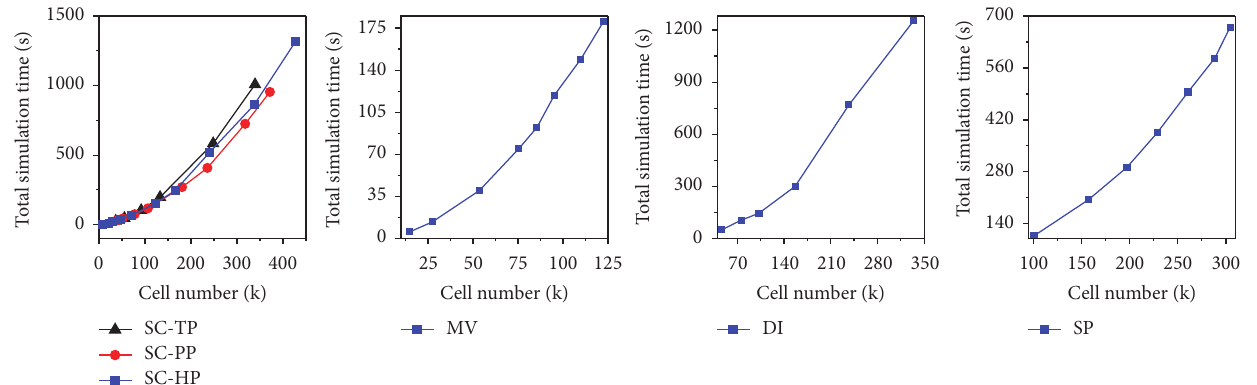
Figure 21: Regularity for the total simulation time.